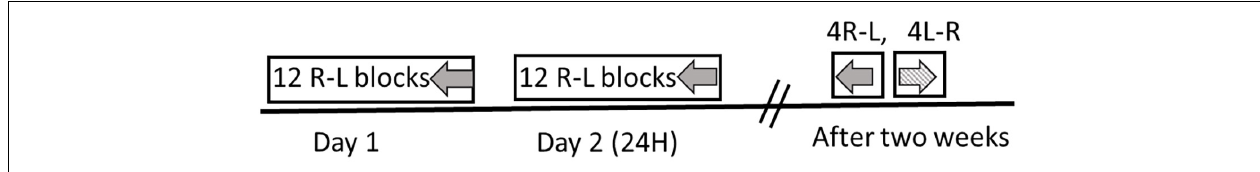
FIGURE 2 | ILT research plan. On Day 1, Day 2, and the first four blocks, 2 weeks after training (retention testing): movement progress is from right to left (R–L; as in Hebrew writing). On the four blocks of the transfer task, movement progress is from left to right (L–R).